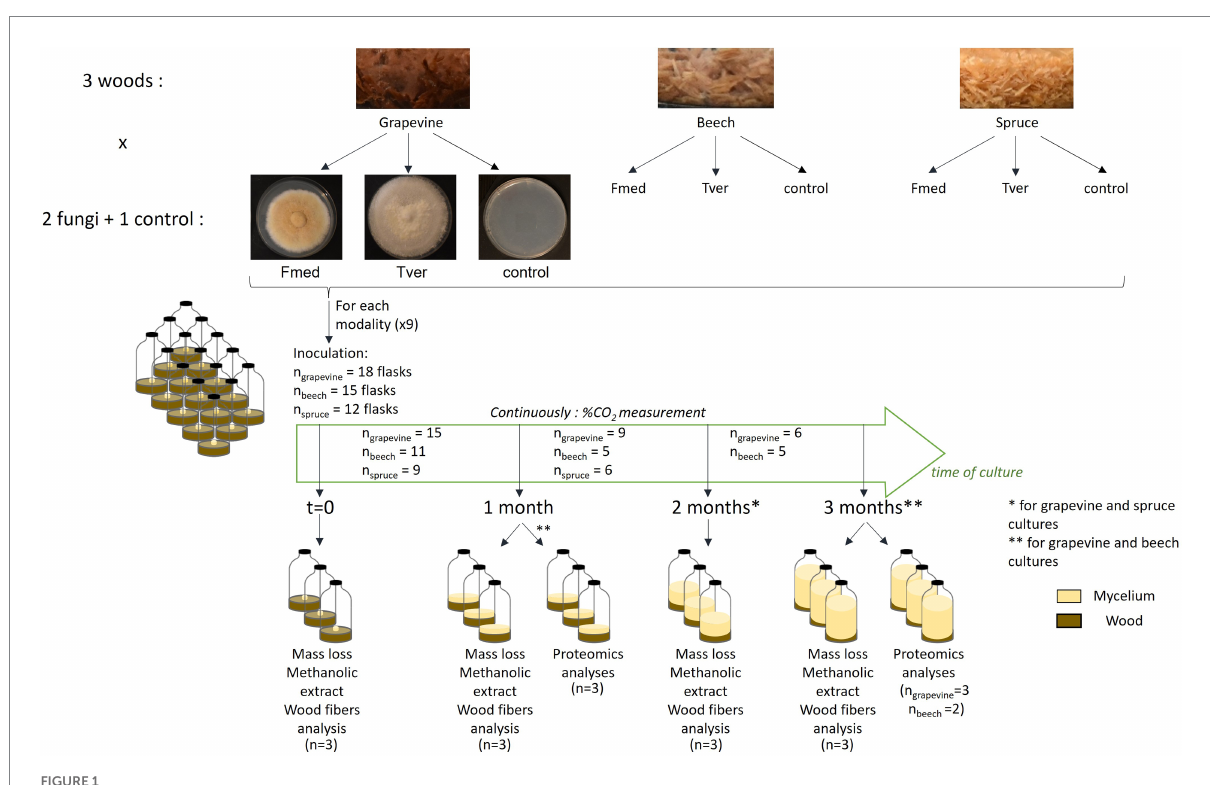
FIGURE 1 Experimental